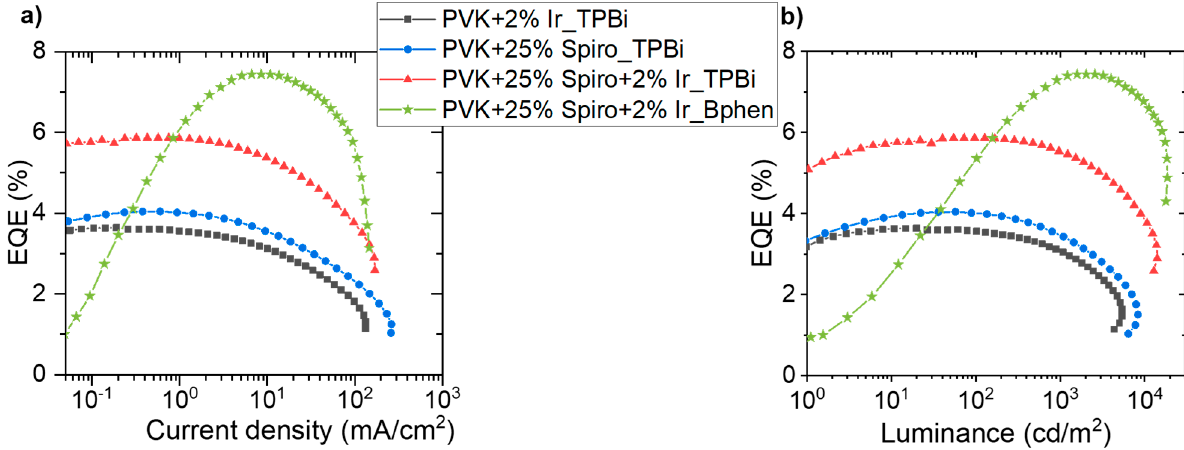
Figure 6. Working parameters of OLEDs with different emissive layers: PVK + 2 wt% Ir, PVK + 25 wt% SpiroAC–TRZ and PVK + 25 wt% SpiroAC–TRZ + 2 wt% Ir. Device structure: ITO/PEDOT:PSS(20 nm)/LEL(65 nm)/TPBi or Bphen(40 nm)/Liq(2 nm)/Ag(100 nm). ( a ) EQE vs current density; ( b ) EQE vs luminance.